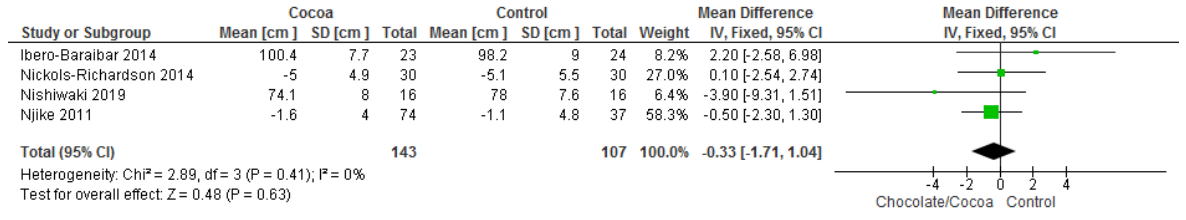
Figure 12. Forest plot of comparison: chocolate versus control, with the outcome - body fat percentage (%). One study [32] measured additional anthropometric parameters individually and did not show any significant difference in all the outcomes measured, which is waist hip ratio. The graphical representations of all above findings are shown in Figure S8. 3.3.5. Blood Glucose Results show that consuming chocolate (210 participants) was not significantly dif- ferent from control (241 participants) in affecting fasting plasma glucose (MD = 1.14 mg/dL; 95% CI = − 0.50, 2.77; five studies; I 2 = 1%). Certainty-of-evidence was moderate for the five trials due to unclear or high risk of bias for allocation concealment, blinding of participants and personnel, blinding of outcome assessment, and other bias. The graphical representation of these findings is shown in Figure 13. All four studies where considerably homogenous with I 2 of 1% [32,34,36,38,41]. Figure 13. Forest plot of comparison: chocolate versus control, with the outcome — fasting plasma glucose (mg/dL). Nich- ols-Richardson (2014) and Nijike (2011) reported mean changes and their respective SD, instead of mean scores. 3.3.6. Cognitive Function Results show that consuming chocolate (116 participants) was not significantly dif- ferent from control (111 participants) in affecting attention time for completing tasks (MD = − 0.67 seconds; 95% CI = − 3.38, 2.05; two studies; I2 = 0%) and processing speed and cog- nitive flexibility (MD = − 3.14 seconds; 95% CI = − 11.55, 5.28; two studies; I2 = 67%).